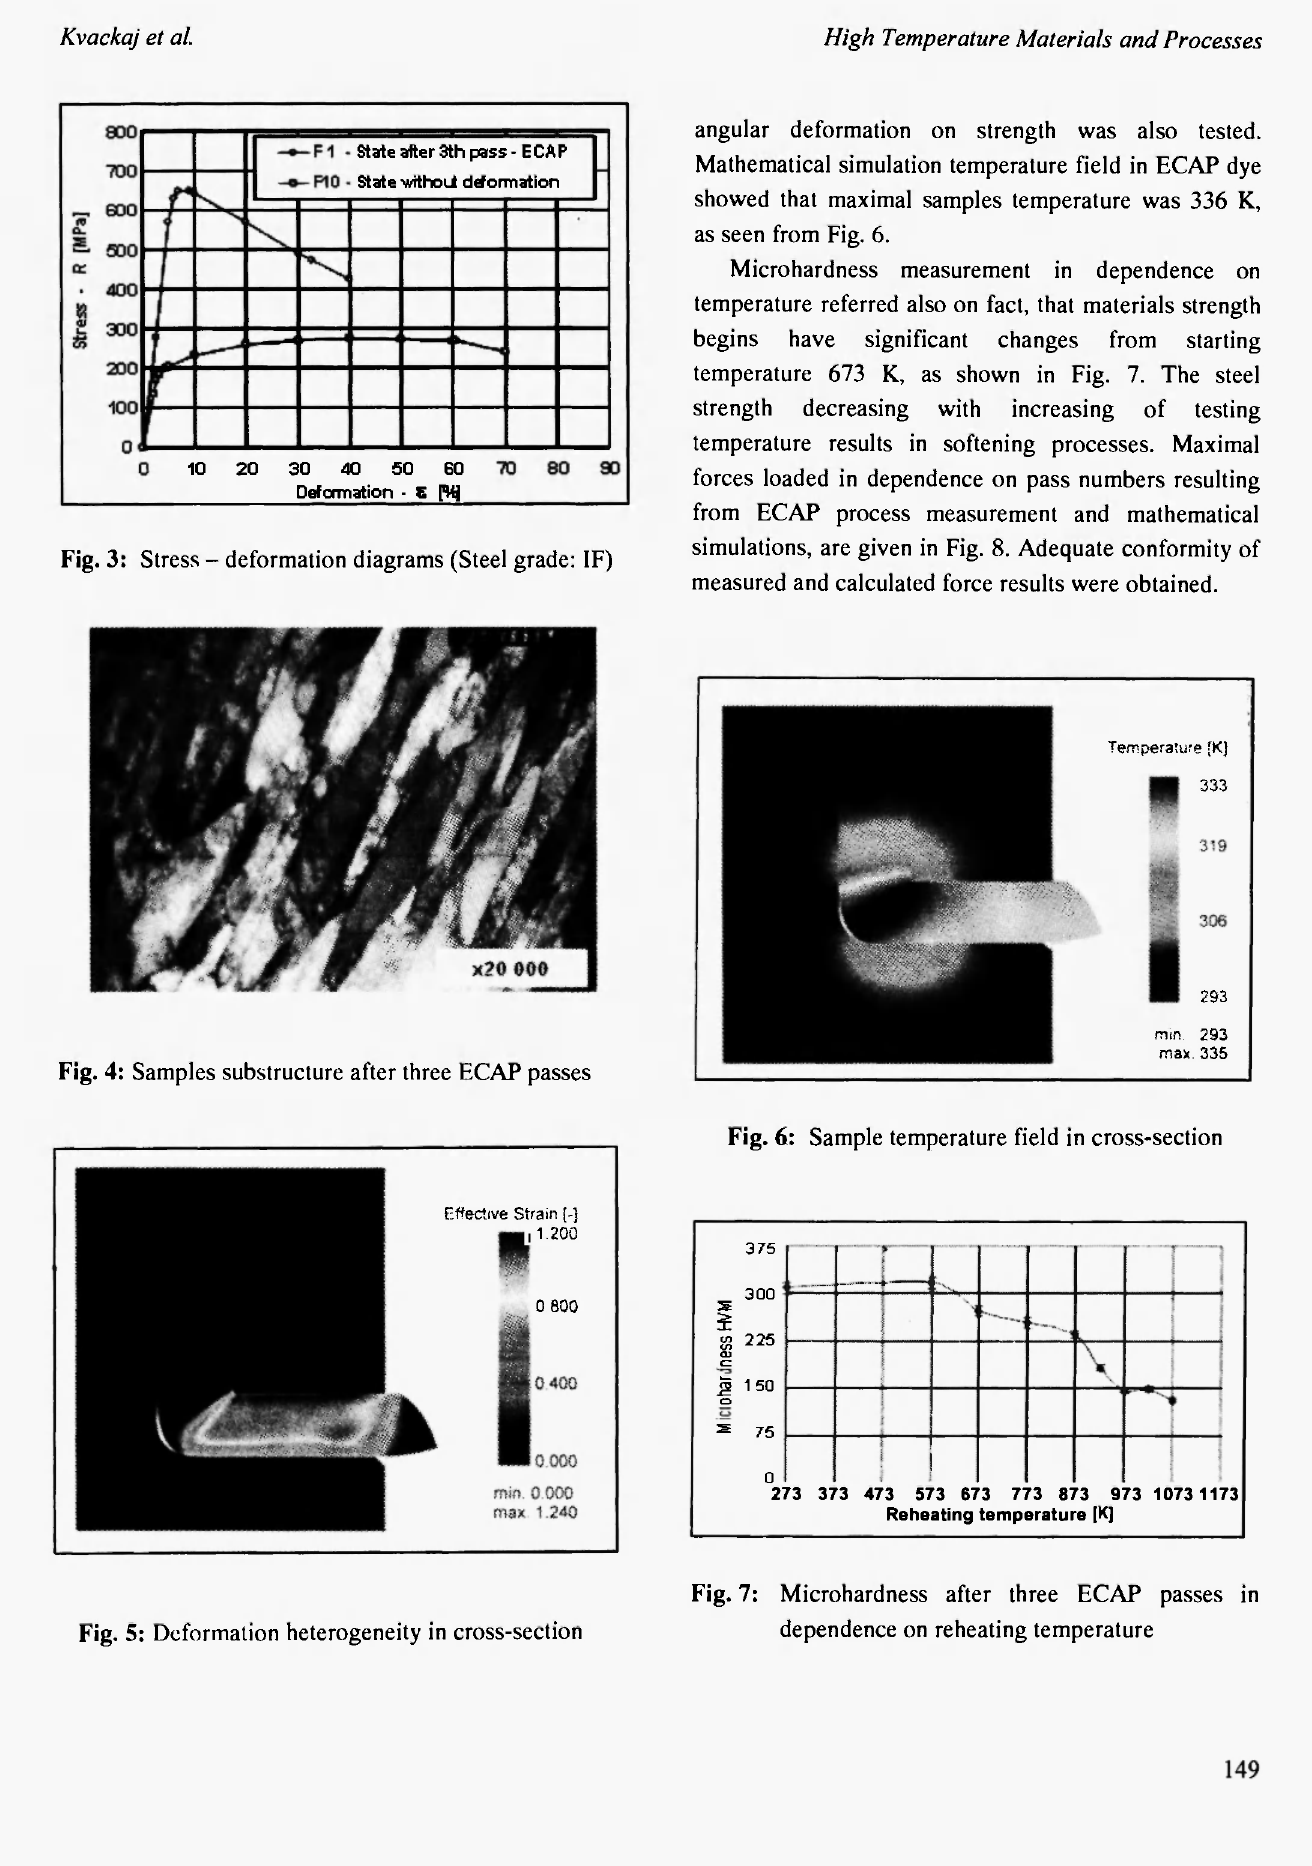
Fig. 5: Deformation heterogeneity in cross-section